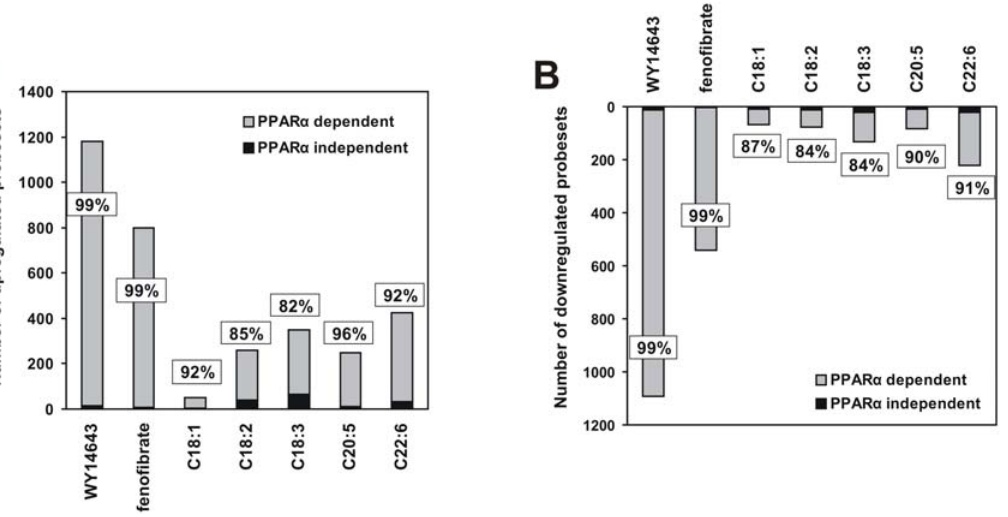
Figure 2. PPAR a -dependent regulation of gene expression by dietary unsaturated fatty acids. Bars show number of up- (upper panel) and downregulated (lower panel) probesets in the different treatment groups. The number of probesets regulated by unsaturated fatty acids in a PPAR a -dependent manner (light bars, not changed in the PPAR a 2 / 2 mouse), or PPAR a -independent manner (dark bars, changed in wild-type and PPAR a 2 / 2 mice) are shown, with percentage PPAR a dependence indicated. Probesets were considered statistically significantly regulated if P , 0.01.